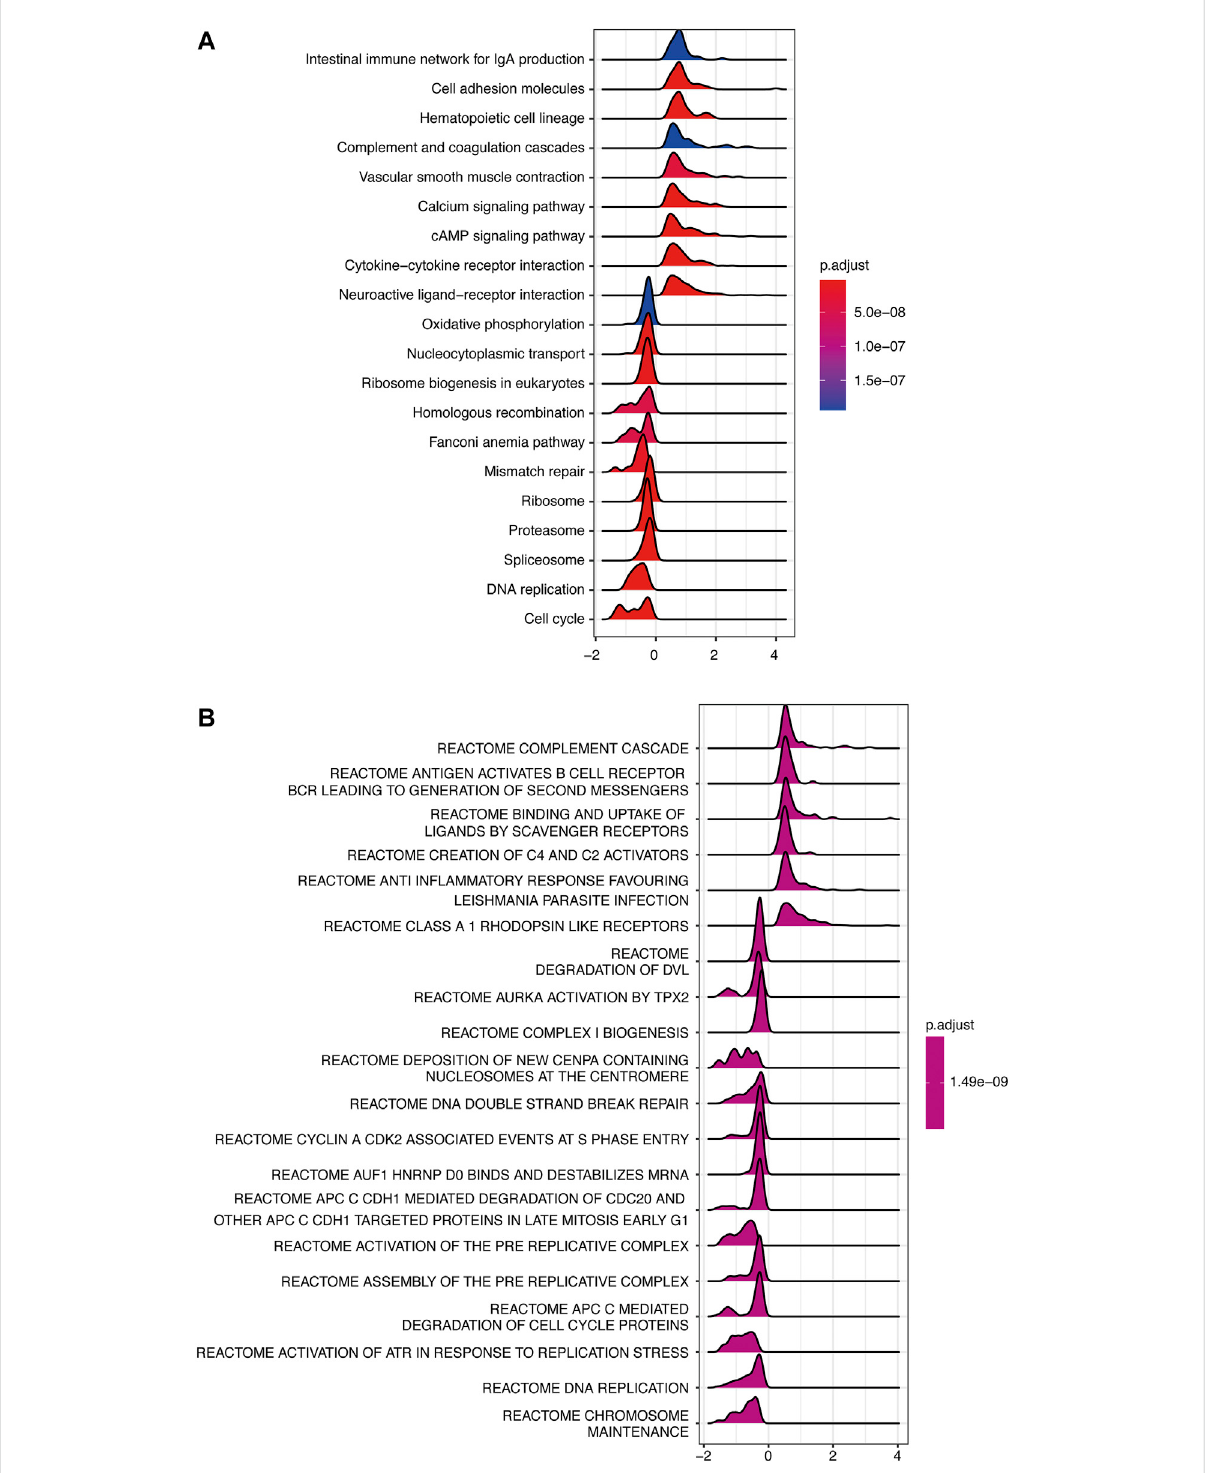
FIGURE 5 GSEA of samples between high- and low-INMT groups in TCGA-LUAD cohort. Ridge plot of gene sets of KEGG (A) and Reactome (B) enriched in the high- or low-INMT group in TCGA-LUAD cohort. The X-axis represents the normalized enrichment score (NES), and the color represents the p -value adjusted by FDR. The top enriched signaling pathways are shown in the fi gures. GSEA, gene set enrichment